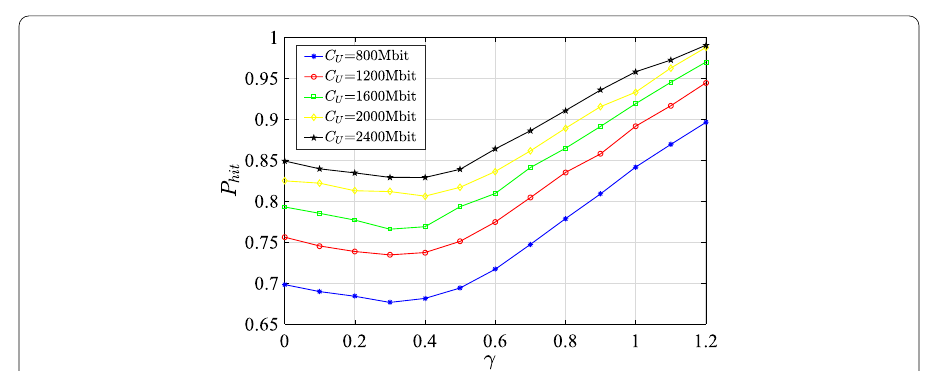
Fig. 7 The effect of γ on P hit under different C